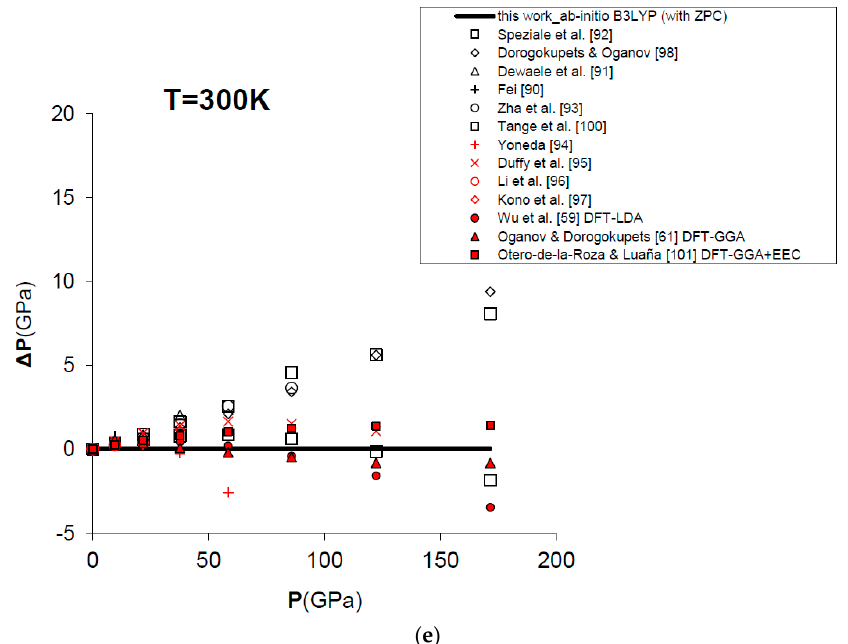
Figure 7. Ab initio B3LYP P–V–T equation of state (FPMG-EOS) of MgO, calculated with and without zero-point correction (ZPC) (dashed and bold curves, respectively; see Equations (14) and (15): ( a ) at T = 300 K; ( b ) at T = 1000 K; ( c ) at T = 2000 K; ( d ) at T = 3000 K; ( e ) deviation plot at T = 300 K. Calculated results of this work are compared to selected experimental data obtained by hydrostatic or quasi-hydrostatic compression in the diamond-anvil cell [90–93] and ultrasonic measurements [94–97]. The results of semi-empirical assessments [98,100], other ab initio LDA [59], GGA [61] and empirically-corrected GGA [101] calculations and MD simulations [60,84] are also shown for comparison.